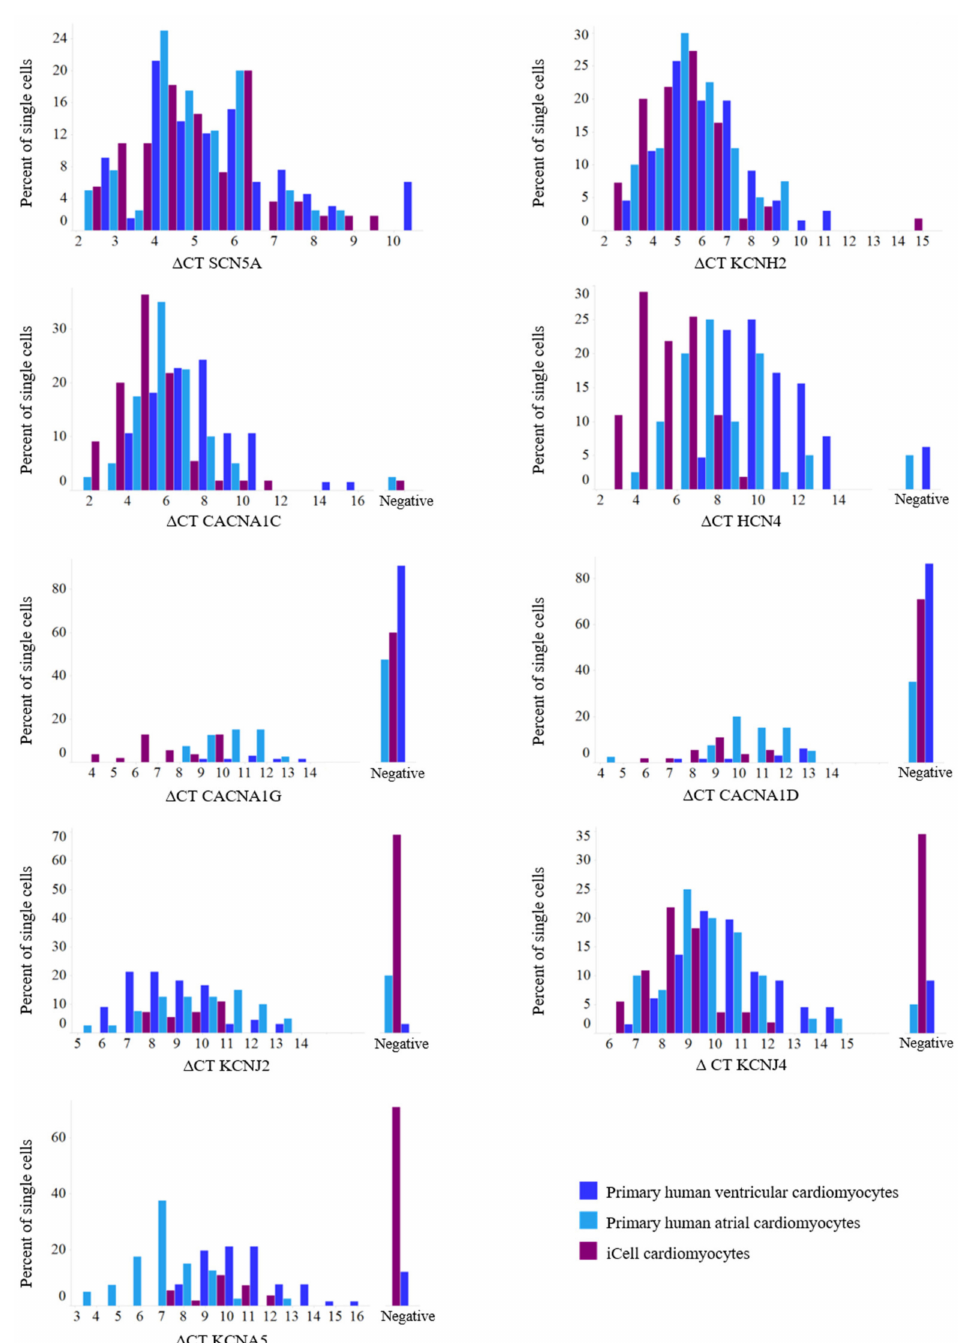
Figure 1. Histograms of expression parameters. Comparisons of distributions of single-cell expression data ( ∆ CT) between atrial and ventricular human primary cardiomyocytes and iCell cardiomyocytes. For total n see Table 3. While for some ion channels (SCN5A, KCNH2, CACNA1C, and KCNJ4) the distributions between primary human atrial and ventricular cardiomyocytes are comparable, the distributions of HCN4, CACNA1D, CACNA1G, and KCNA5 are left-shifted (higher expression) in primary human atrial cardiomyocytes compared to primary human ventricular cardiomyocytes. With respect to KCNJ2, distribution is left-shifted (higher expression) for human primary ventricular cardiomyocytes compared to their atrial counterpart. Comparing distributions between the two primary cardiomyocyte groups and iCell cardiomyocytes shows a shift to the left (higher expression) for the pacemaking-associated ion channels HCN4, CACNA1G, and CACNA1D in iCell